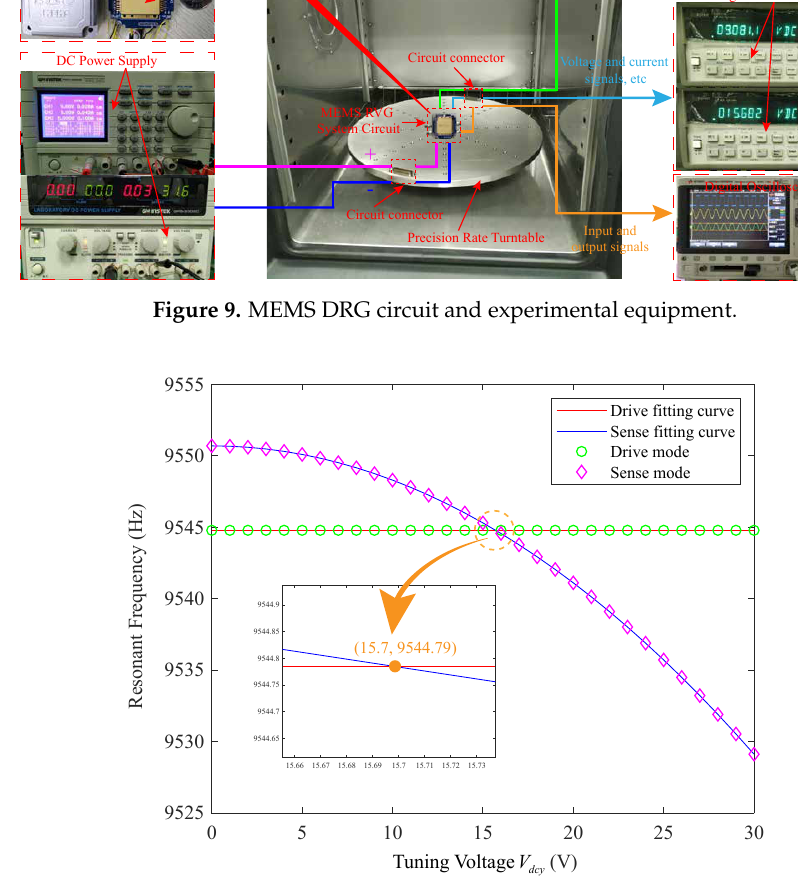
Figure 10. Relationship between two mode resonant frequencies and tuning voltage after quadrature stiffness